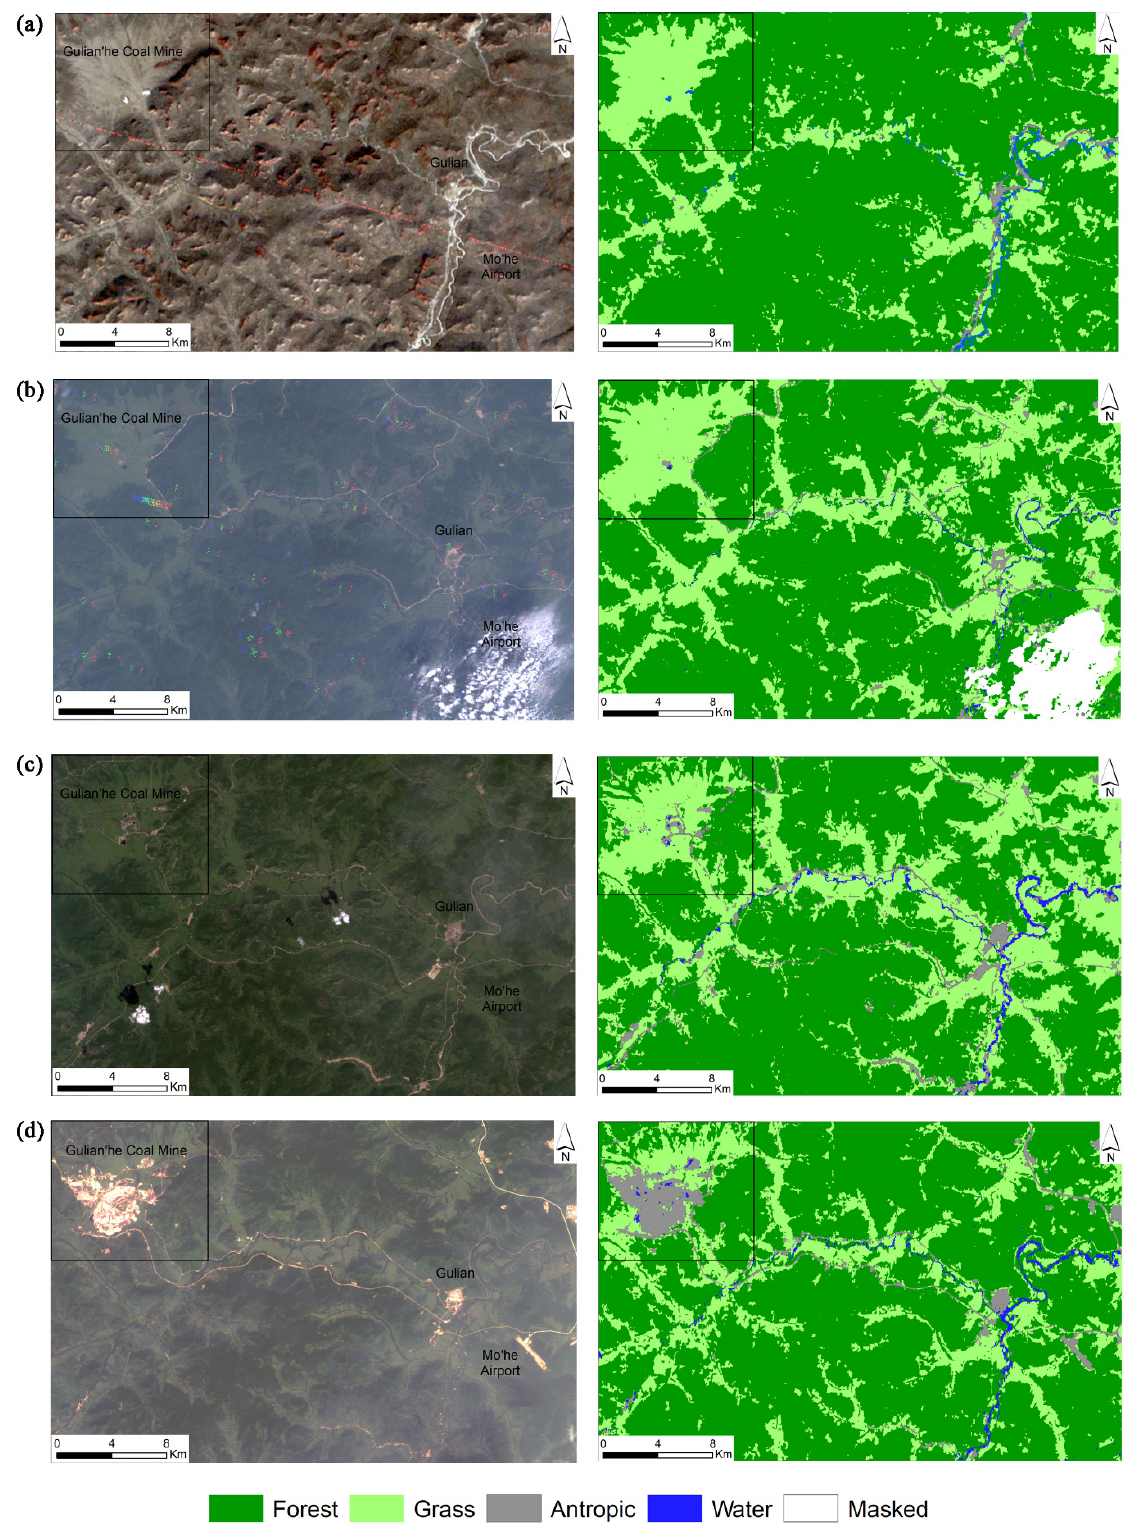
Figure 2. Examples of Landsat composites (left side, band combination: near-infrared-red-green for 1973 and red-green-blue for other years) and the land cover classes (right side) for the Hola Basin, Northeast China, in ( a ) 1973, ( b ) 1986, ( c ) 2000, and ( d ) 2019. The black box marks the location of the Yueya Lake and the Gulian’he coal mine.